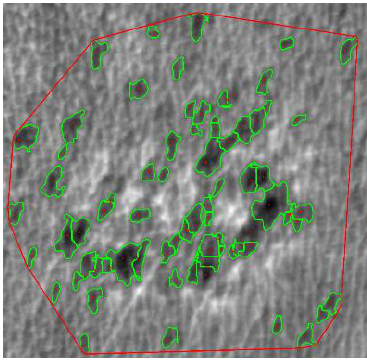
Figure 10. Visualisation of the results on the basis of a sample with very low structured goose bumps